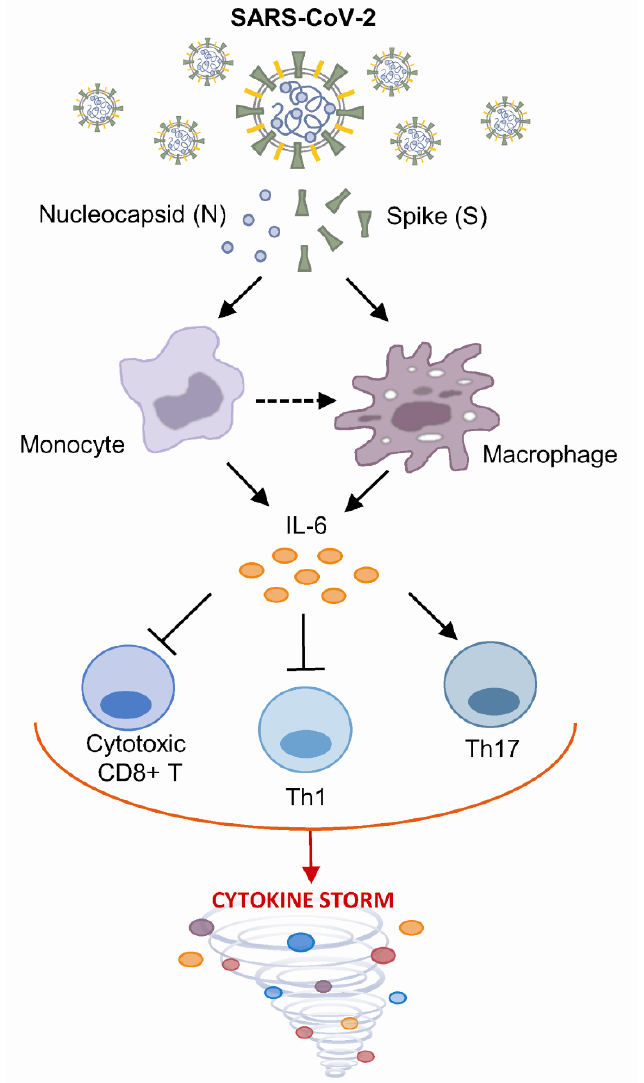
Figure 5. Schematic presentation of SARS-CoV-2 protein-dependent activation of monocytes/ macrophages, leading to IL-6 release and cytokine storm.